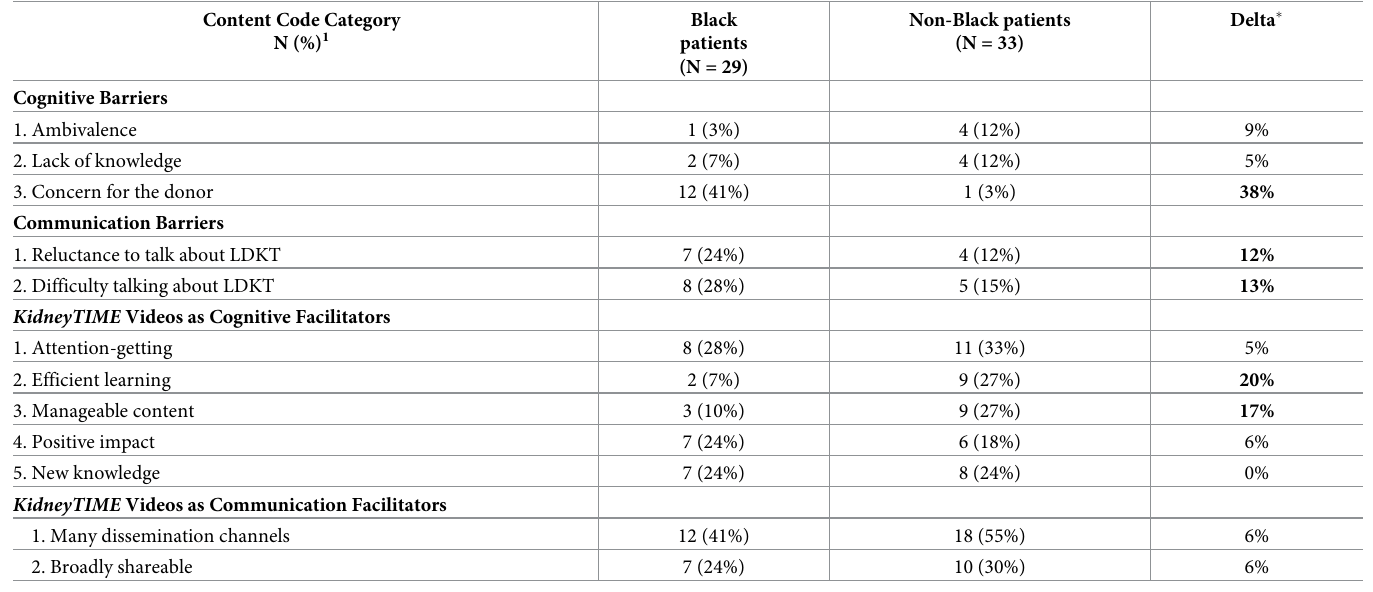
Table 2. Number and proportion of Black and non-Black patient-participants that made at least one statement pertaining to each content code category. Content Code Category N (%)